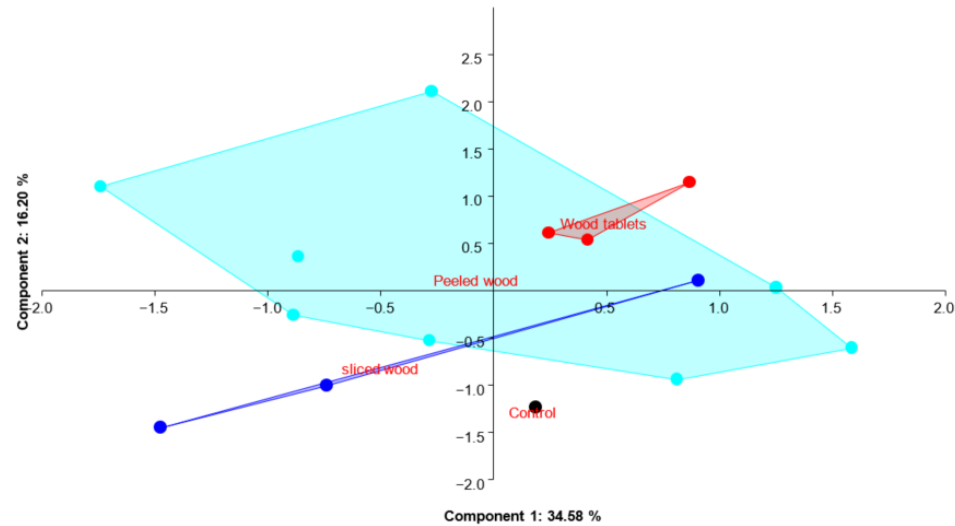
Figure 5. PCA score plot representing spirits aged with different alternative products. Results of NIR data. The graph highlights the effect of the shape of wood fragments on spirit composition. Black, control sample; light blue, peeled wood; red, wood tablets; dark blue, sliced wood.